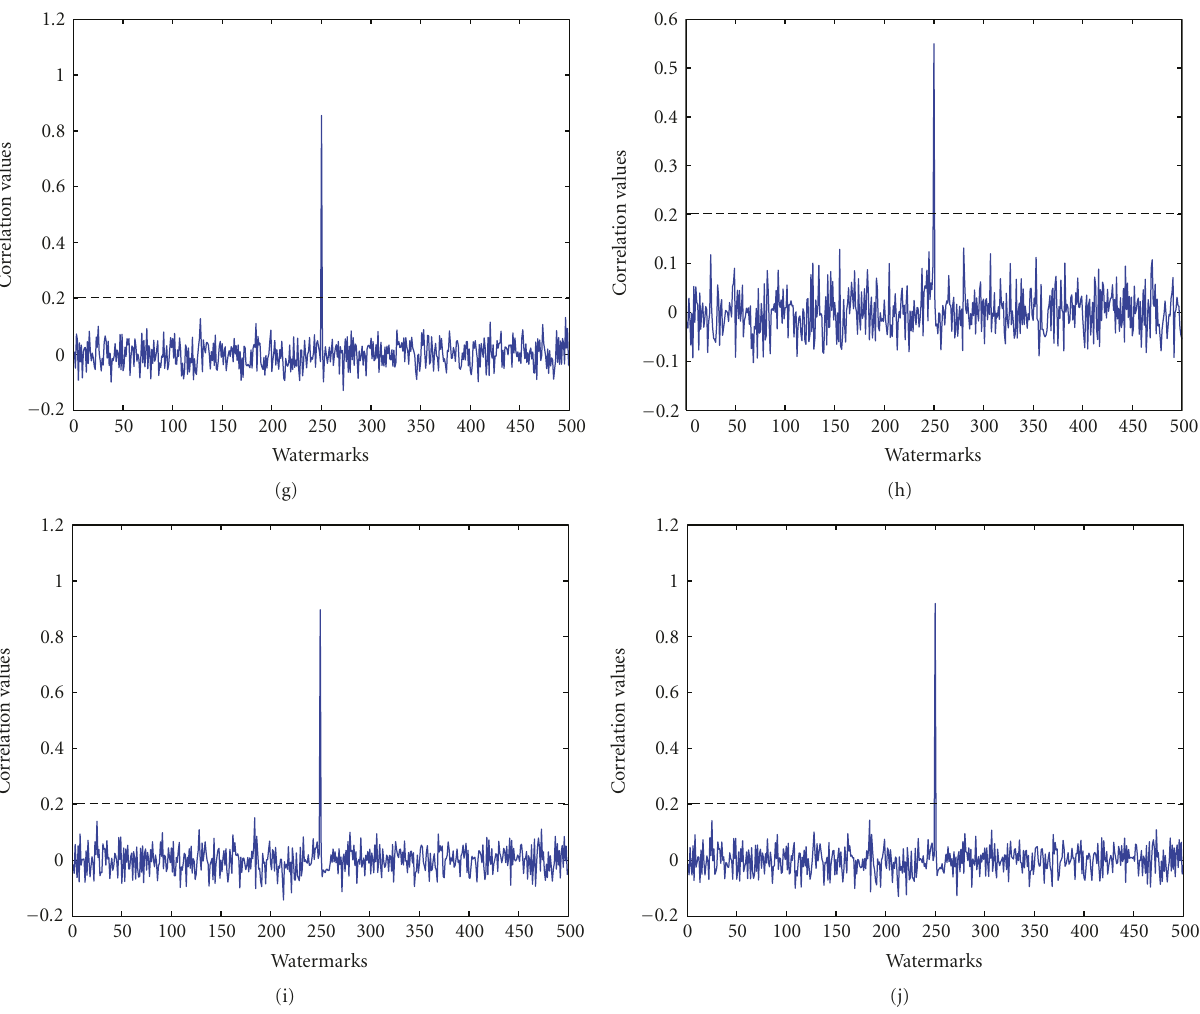
Figure 3: Correlation detector response under (a) AWGN ( σ 2 = 0 . 025), (b) AWGN ( σ 2 = 0 . 85), (c) Salt and Pepper noise, (d) Wiener Filtering, (e) Median Filtering, (f) JPEG Compression ( Q = 10%), (g) JPEG Compression ( Q = 50%), (h) Rotation (5 ◦ ), (i) Cropping (50 column), (j) Cropping (100 column) attacks.